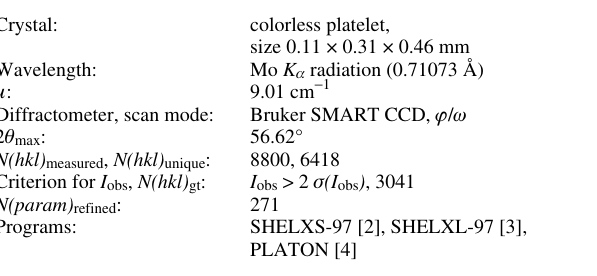
Table 1. Data collection and handling.